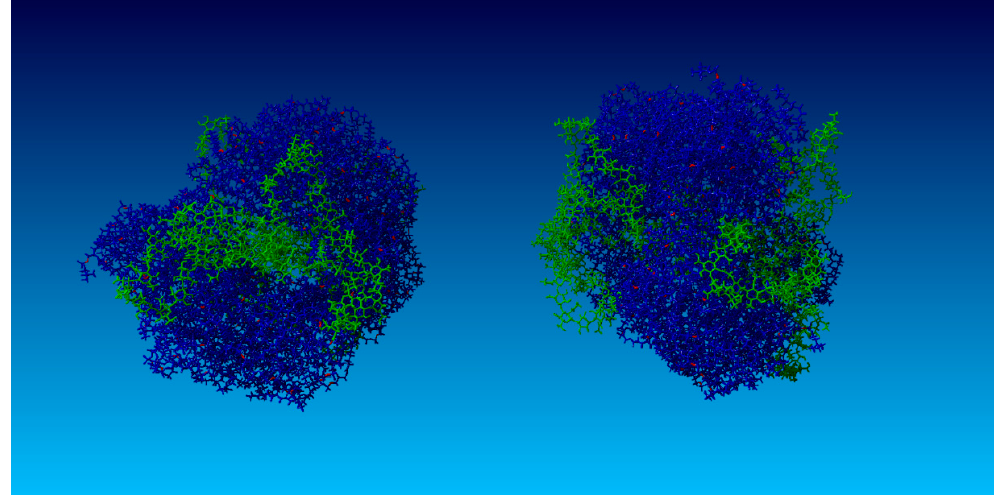
Figure 20. Simulation snapshot of the 192 nm HA chain ( Left ) adsorbed into a DPPC vesicle ( Right ). HA molecules are green and DPPC molecules are blue. Red depicts oxygen atoms localized at hydrophilic DPPC head groups.